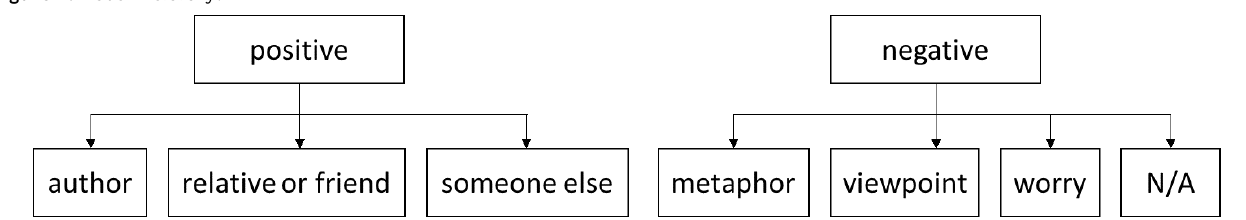
Figure 2. Label hierarchy.